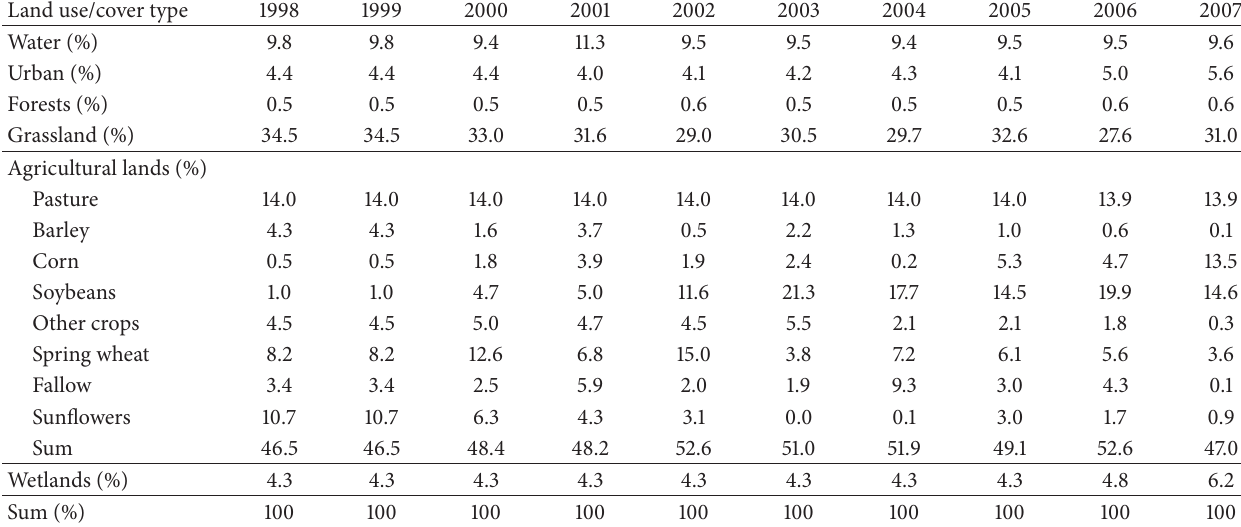
Table 1: Land use/cover types and areal percentages within the study area.